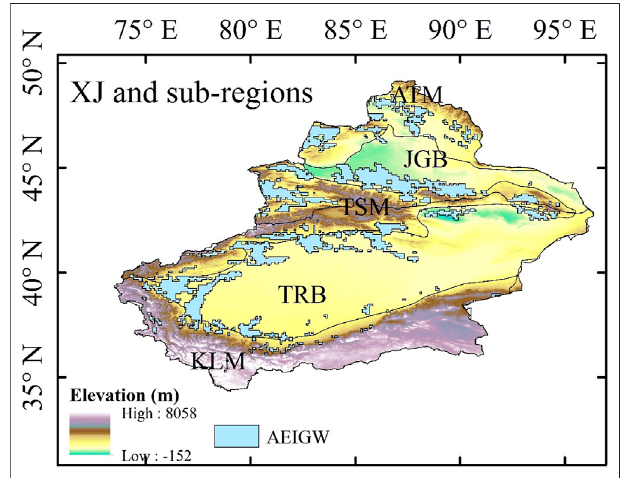
FIGURE 1 | Study area: Xinjiang (XJ) and the locations of the fi ve sub- regions, i.e. Altain Mountainous (ATM), Junggar Basin (JGB), Tianshan Mountainous (TSM), Tarim Basin (TRB) and Kunlun Mountainous (KLM). The black line denotes the boundary of the sub-regions. The blue represents the area of irrigation from groundwater which are extracted from the Global Map of Irrigation Areas (GMIA) V5.0 of the Food and Agriculture Organization of the United Nations, AEIGW: area equipped for irrigation with